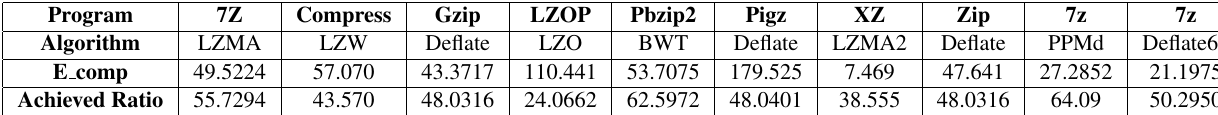
Table 3: The best efficiency value achieved by each program and corresponding algorithm.